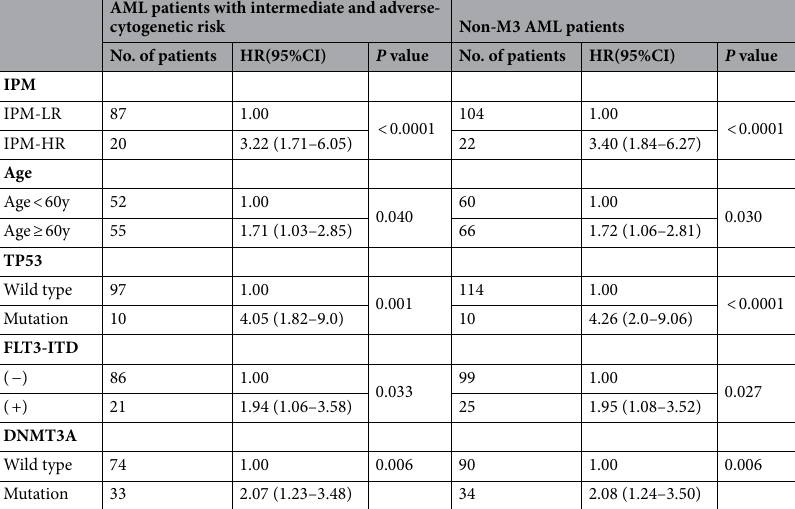
Table 1. Independent prognostic factors for OS of AML patients in TCGA cohort.